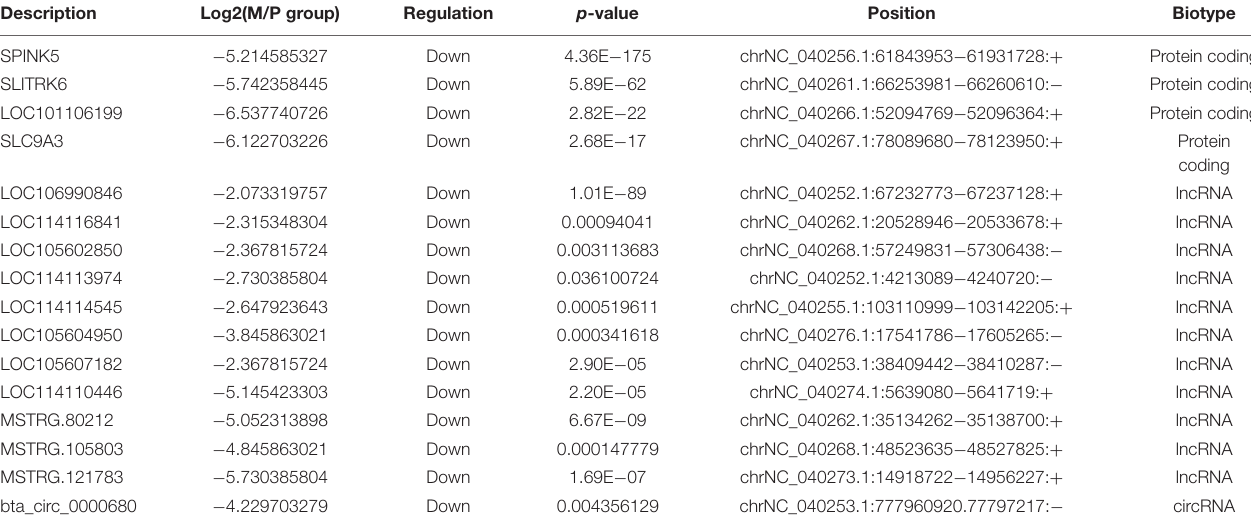
TABLE 3 | The highest expression of DERs in M group vs. P group of RNA-Seq. Description